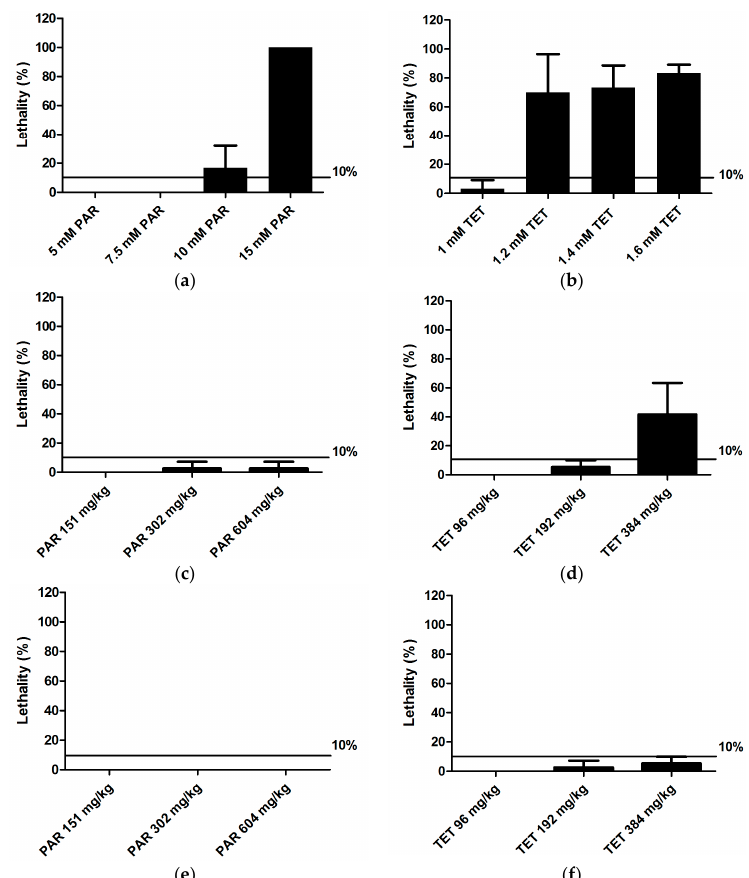
Figure 1. Lethality in Tg( fabp10a:DsRed ) zebrafish larvae after immersion ( a , b ); yolk injection ( c , d ) and pericardial injection ( e , f ) of paracetamol ( a , c , e ) and tetracycline ( b , d , f ). Analysis was performed after three days of treatment (immersion) or three days after treatment (injection), at 6 days post-fertilization (dpf). A total of 10 and 12 larvae were used individually per condition for immersion and injections, respectively. The experiment was performed in triplicate and data were pooled. The results are expressed as percentage of dead larvae relative to the total larvae (mean ± SD). PAR: paracetamol; TET: tetracycline. Table 1. Compound concentrations used for hepatotoxicity testing